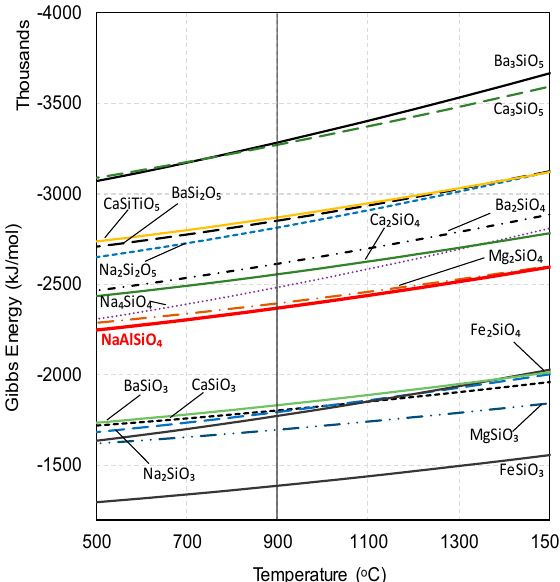
Figure 1. Comparison of Gibbs free energy of phase formation of several silicate species throughout the temperature range by Factsage 7.0™ database (Version 7.3, Thermfact/CRCT (Montreal, QC, Canada) and GTT-Technologies (Aachen, Germany)), with silica notably favoring barium presence.